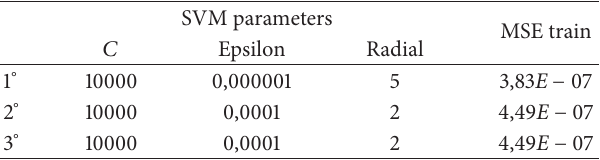
Table 6: High concentration: classification errors using 176 vari- ables.